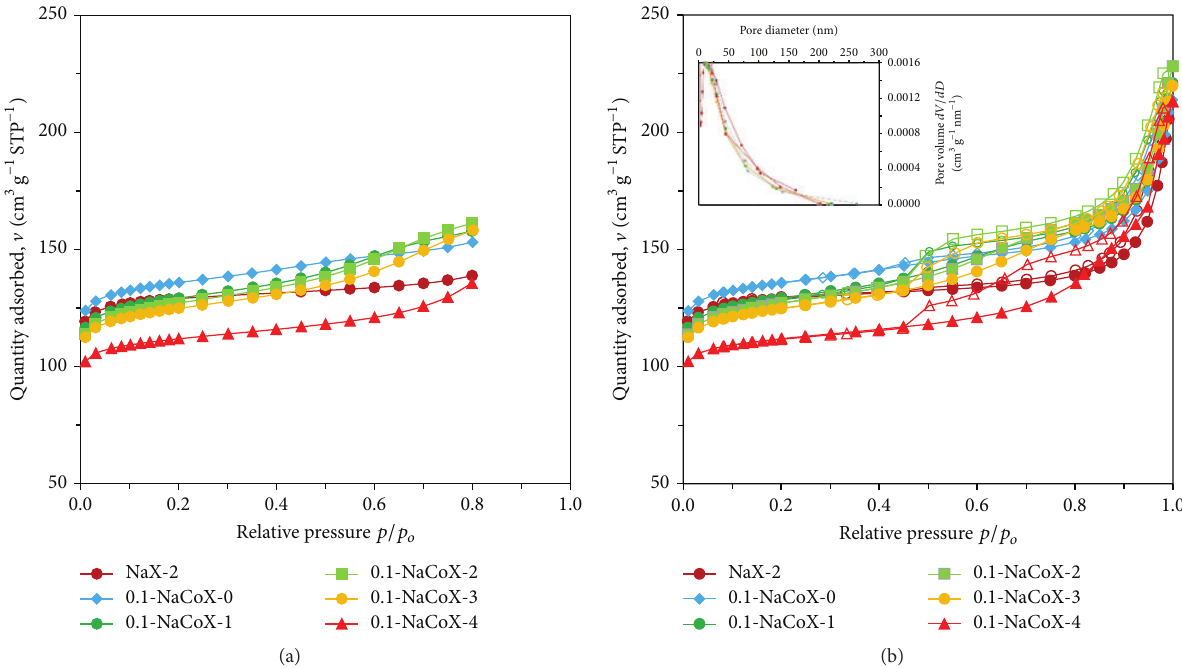
Figure 6: 𝑡 -plot isotherms (a) and N 2 adsorption (solid symbols)/desorption (open symbols) isotherms (b) of NaX and thermally treated 0.1-NaCoX